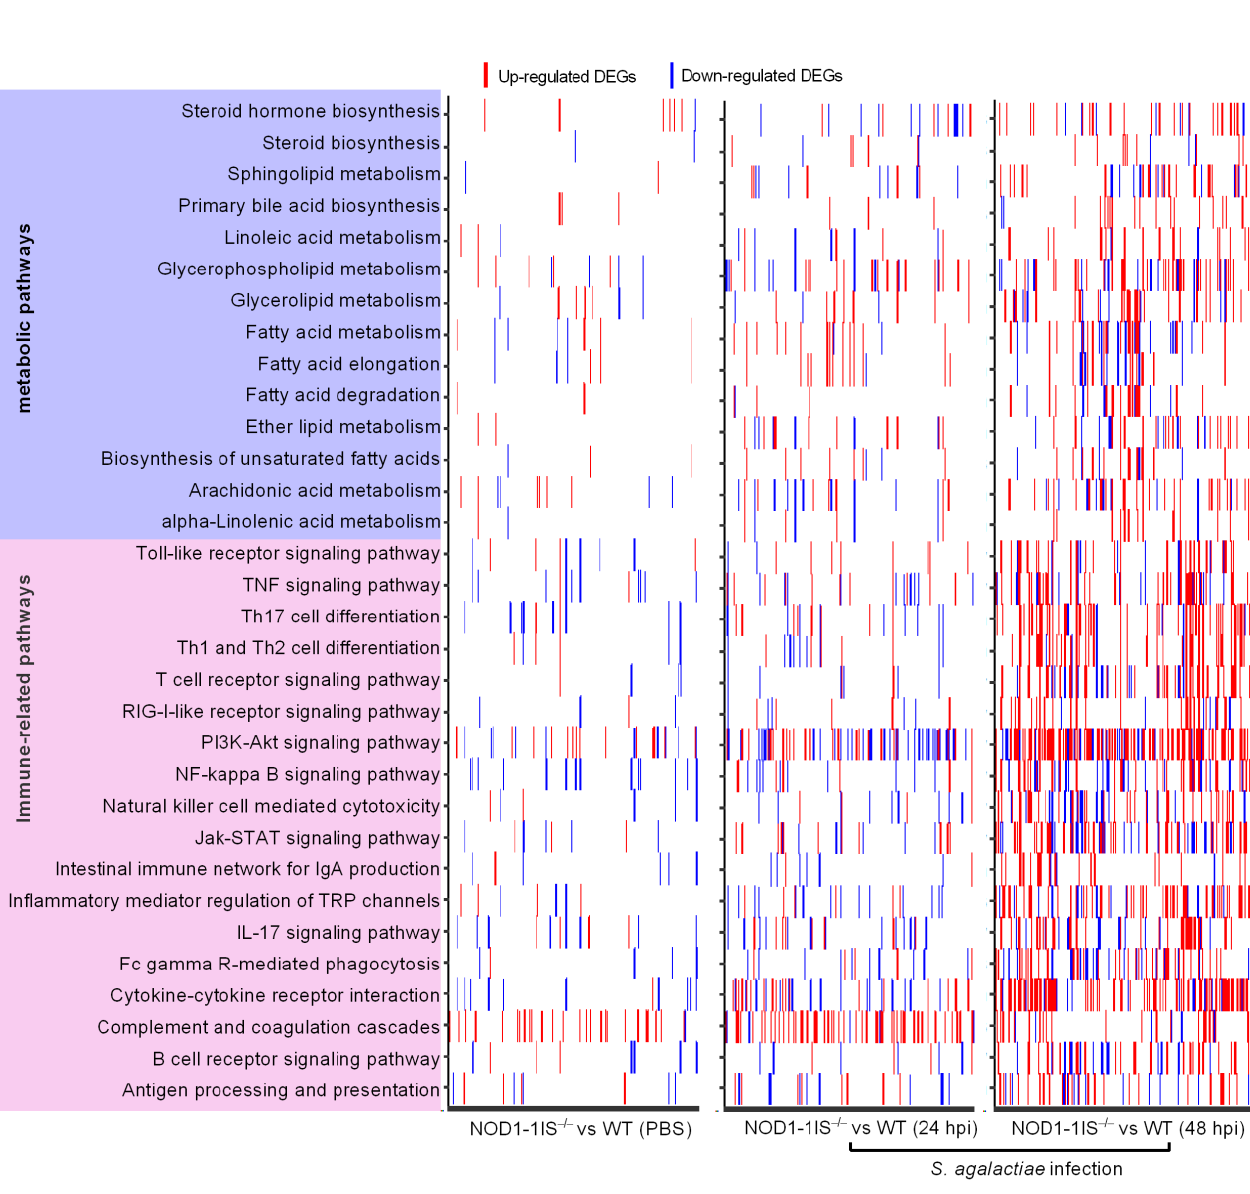
Figure 2. Heatmap presenting DEG profiles of each of the enriched immune-related and lipid metabolism pathways. The horizontal axis represents DEGs, and the vertical axis represents the enriched pathways. The existence of up-regulated DEG in a pathway is highlighted in red and down-regulated DEG is blue.